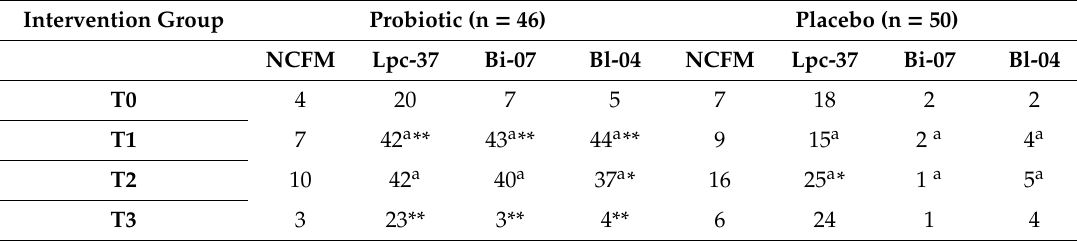
Table 2. Prevalence of subjects with detectable levels of the studied probiotics; Lactobacillus acidophilus NCFM, Lactobacillus paracasei Lpc-37, Bifidobacterium lactis Bi-07, and B. lactis Bl-04. Where T0 = baseline, T1 = end of antibiotic treatment, T2 = end of probiotic or placebo treatment, and T3 = one week after end of probiotic or placebo treatment (washout).